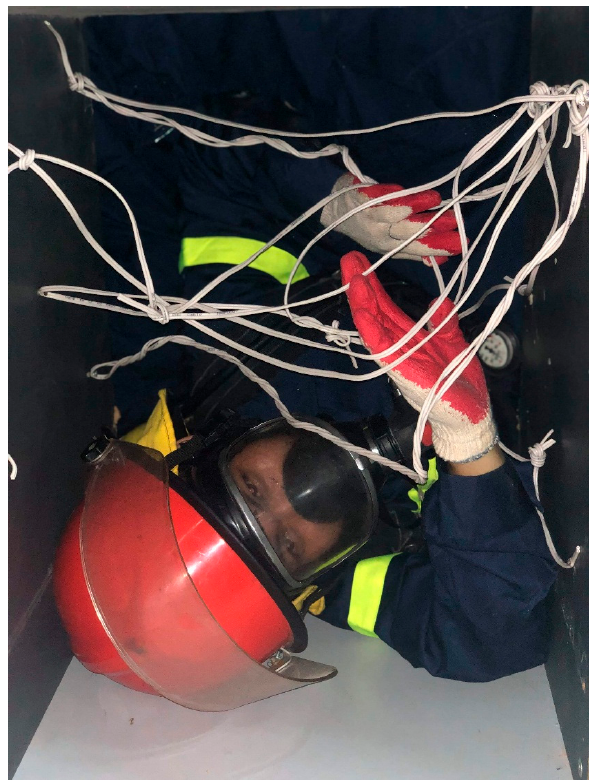
Figure 7. The narrow paths and spaces model.